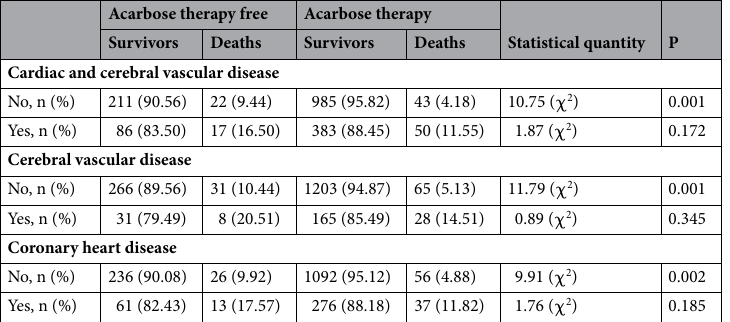
Table 5. Survival ratio of patients with previous CVD in different acarbose treatment groups.